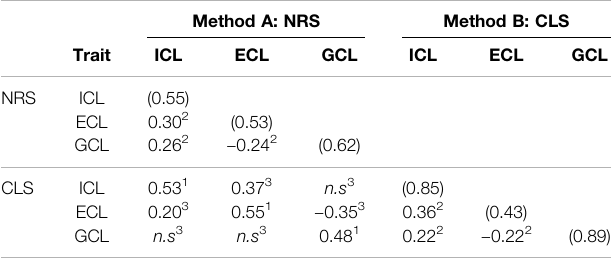
TABLE 3 | Correlation table for MTMM analysis (MTMM matrix; only correlations with p < 0.05 are